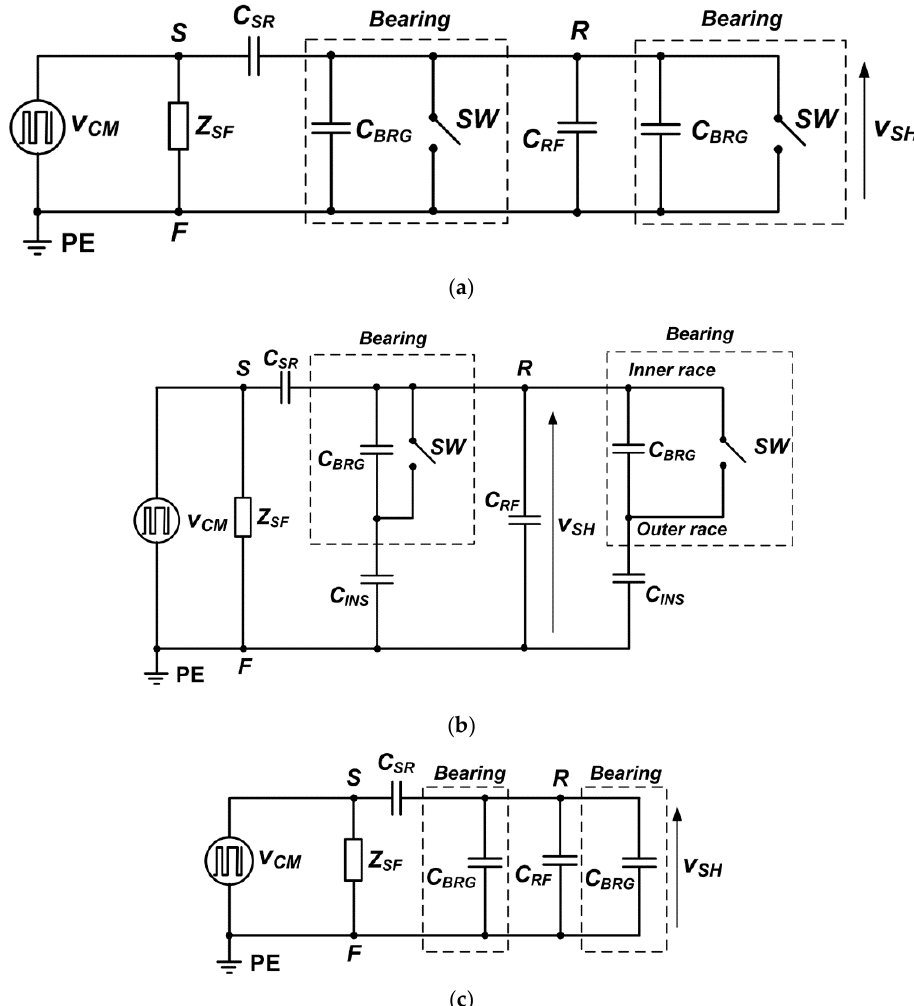
Figure 6. An equivalent scheme of an induction motor common-mode impedance: ( a ) with standard bearings; ( b ) with insulated bearings; ( c ) with hybrid bearings.